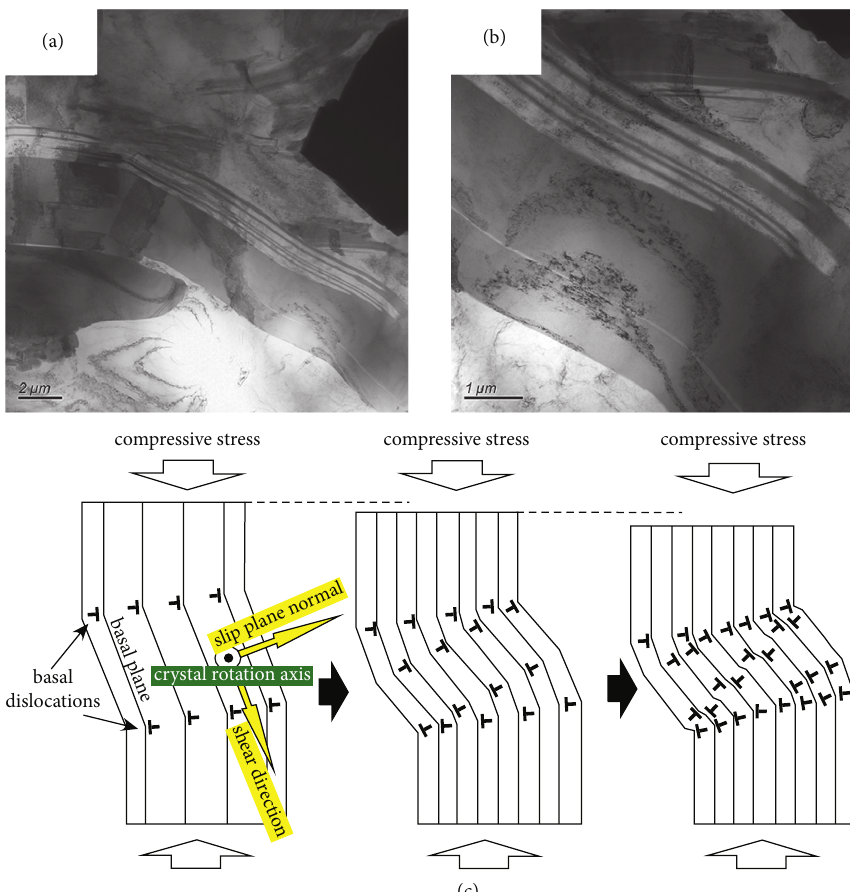
Figure 10: (a, b) The kink bands of LPSO phases in the extruded alloys. (c) The formation mechanism of deformed kink band [30].